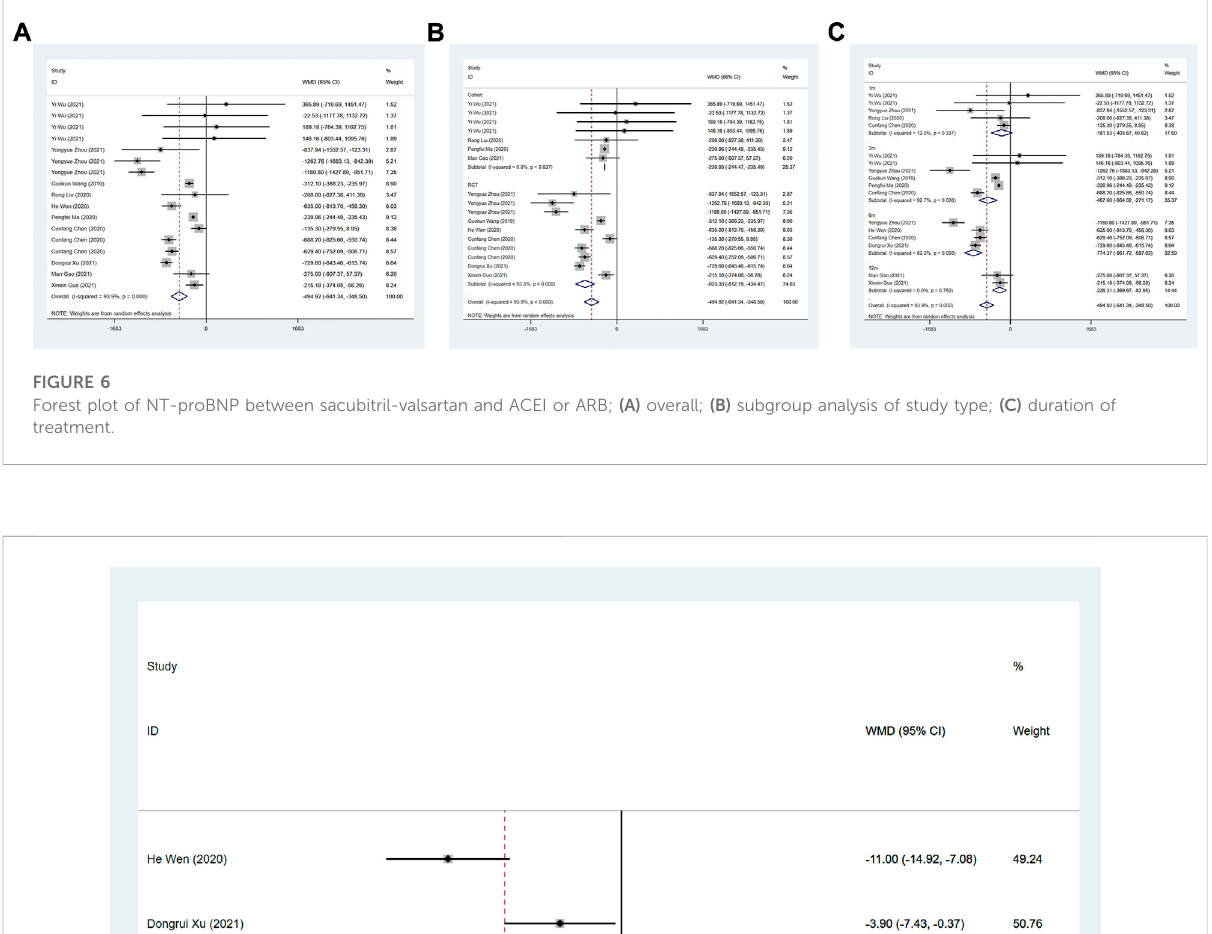
Figure 6A). Based on the subgroup analysis of study type,